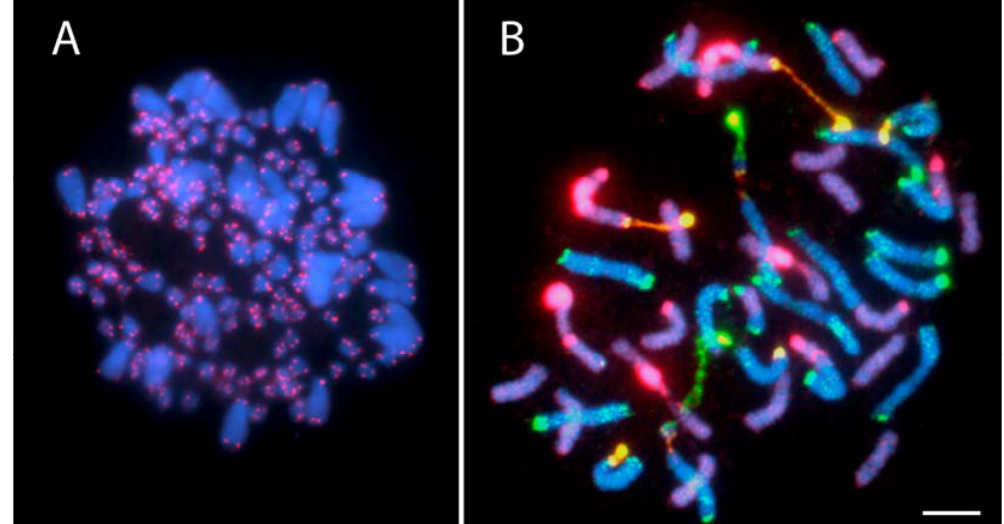
Figure 1. ISH to root tip metaphase spreads (A) FISH to pentaploid Agave fourcroydes (2 n = 5 x = 150) probed with telomere repeat sequences (TTAGGG)n (biotin labelled probe Cy3 signal, pink), chromosomes counterstained with DAPI (blue). (B) GISH to a partial metaphase spread of a Nicotiana sylvestris (2 n = 2 x = 24) x N. tomentosiformis (2 n = 2 x = 24) allotetraploid, which has a chromosome complement of 2 n = 4 x = 48 (see Kostoff hybrid [2]). The spread is probed with total genomic DNA from N. sylvestris (digoxigenin-labelled probe, FITC signal, green) and from N. tomentosiformis (biotin- labelled probe, Cy3 signal, pink), chromosomes are counterstained with DAPI (blue). Depending on the mixture and intensity of the fluorophores other colours are generated. Chromosomes of N. sylvestris origin are shown as cyan and green depending on the strength of the FITC/DAPI signal, while those of N. tomentosiformis origin are violet and magenta depending on the strength of the Cy3/DAPI signal. Areas of yellow chromatin represent 35S ribosomal DNA (rDNA) loci that are hybridised with genomic DNA from both parents. Scale bar: 10